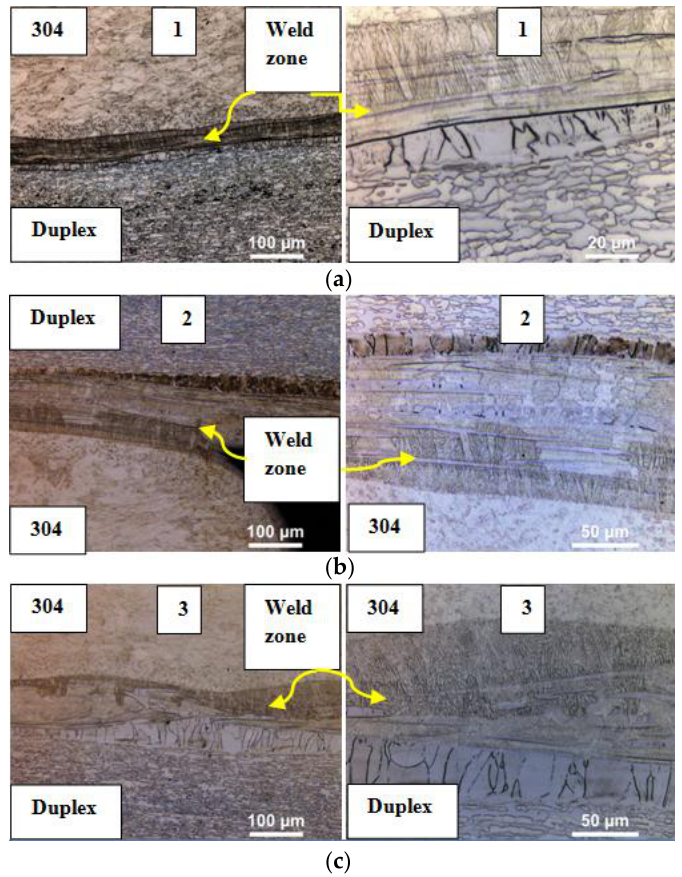
Figure 10. Microstructures of weldments ( a ) 1-140 V, ( b ) 2-160 V, ( c ) 3-180 V. Darker lines in the middle of microstructures indicate the weld center areas.